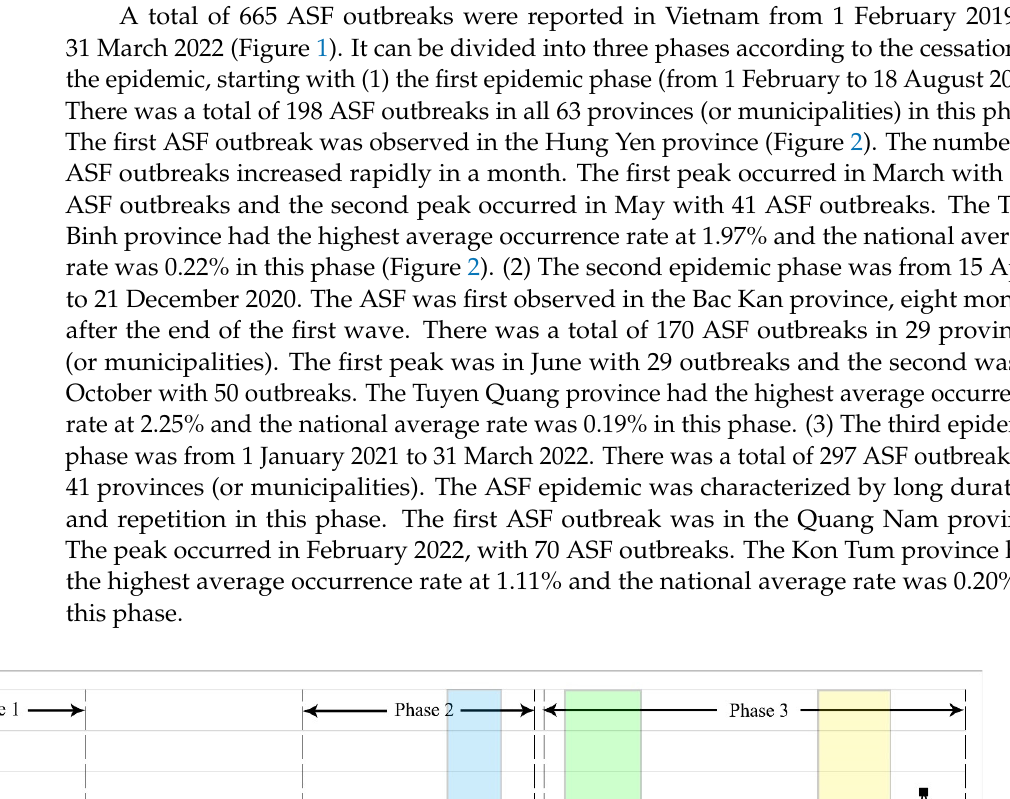
Figure 2. The ASF occurrence rate of each province in Vietnam (February 2019–March 2022). 3.2. The Directional Spreading of the ASF The direction test was statistically significant ( p < 0.01) (Table 2). The average angle in phases 1, 2, and 3 was 278.5°, 264.85°, and 288.56°, respectively. In phase 1 (Figure 3a), the spreading center started in the Thai Binh province and ended in the Ninh Thuan prov ‐ ince with an angular concentration of 0.74, indicating a high consistent southwardly di ‐ rection of spread. In phases 2 and 3 (Figure 3b,c), the angular concentration was 0.35 and 0.18, respectively, indicating high angular variances (0.65 and 0.82, respectively), namely the random spread of monthly outbreaks.